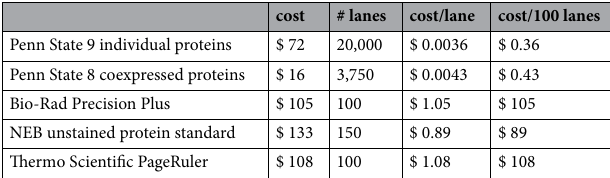
Table 2. Comparison of reagent costs to prepare protein